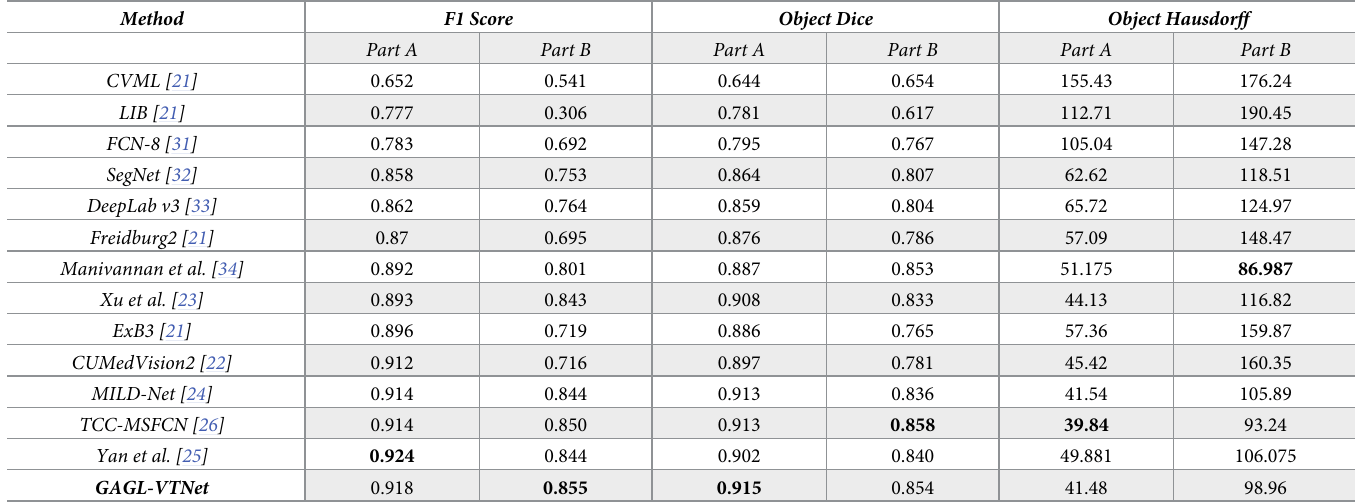
Table 1. Performance comparison to other methods.